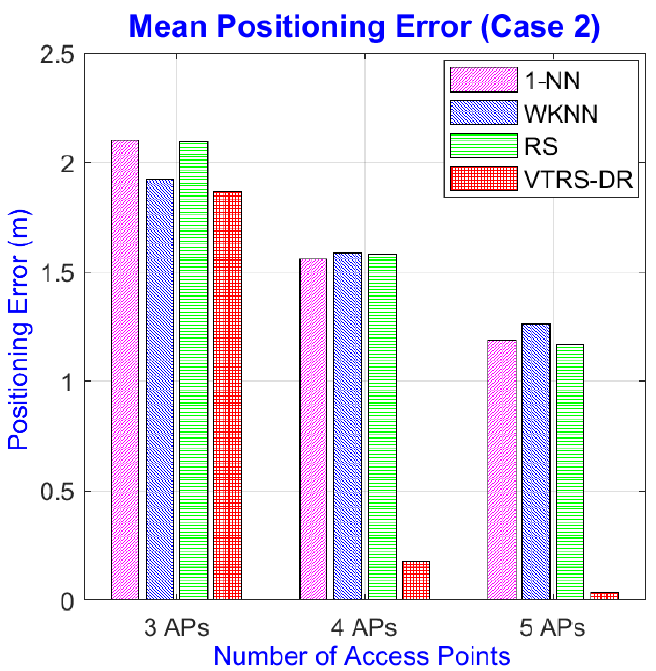
Figure 9. Mean of mean errors of four methods with different numbers of APs in Case 2.